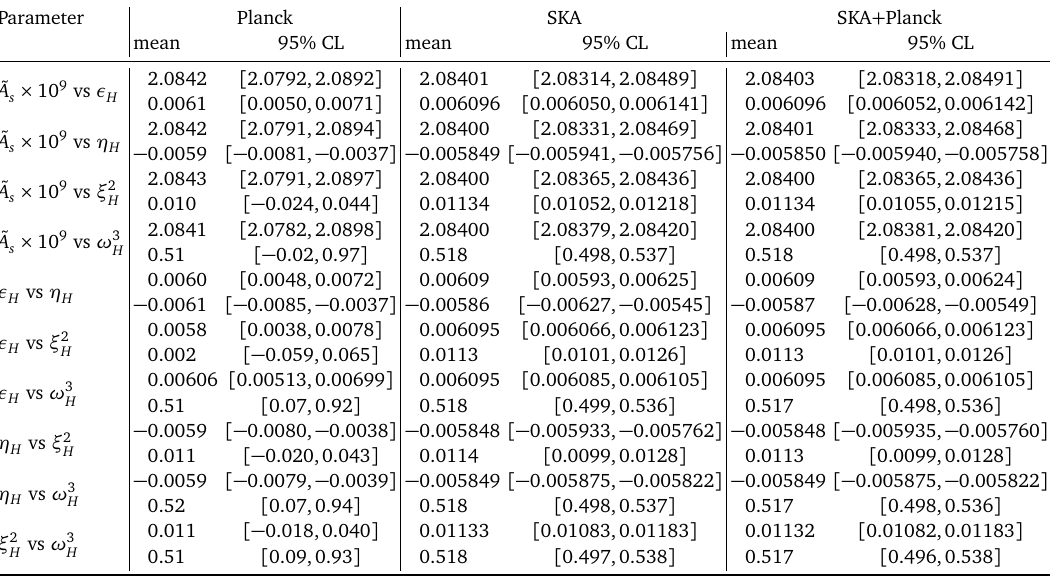
Table 2: Mean values and error bars for 2-dimensional contours of the slow-roll parameters space for the CMB (Fig. 3), 21cm hydrogen spectrum (Fig. 4) and their combination (Fig.